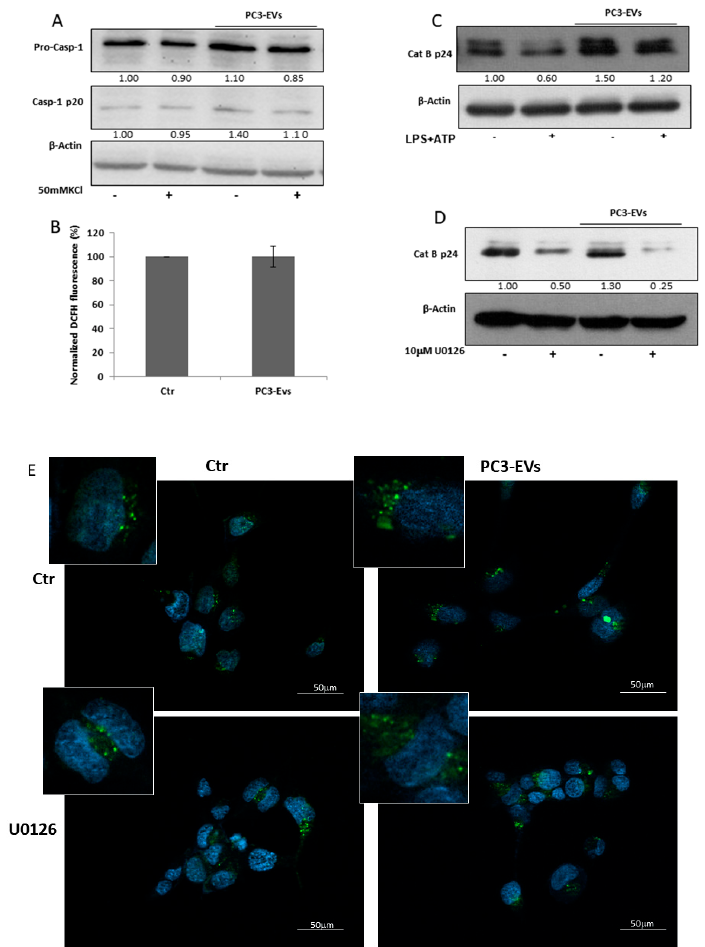
Figure5. PC3-derivedEVstriggercathepsinBactivationandlysosomaldestabilizationviaERK1 / Figure 5. PC3-derived EVs trigger cathepsin B activation and lysosomal destabilization via